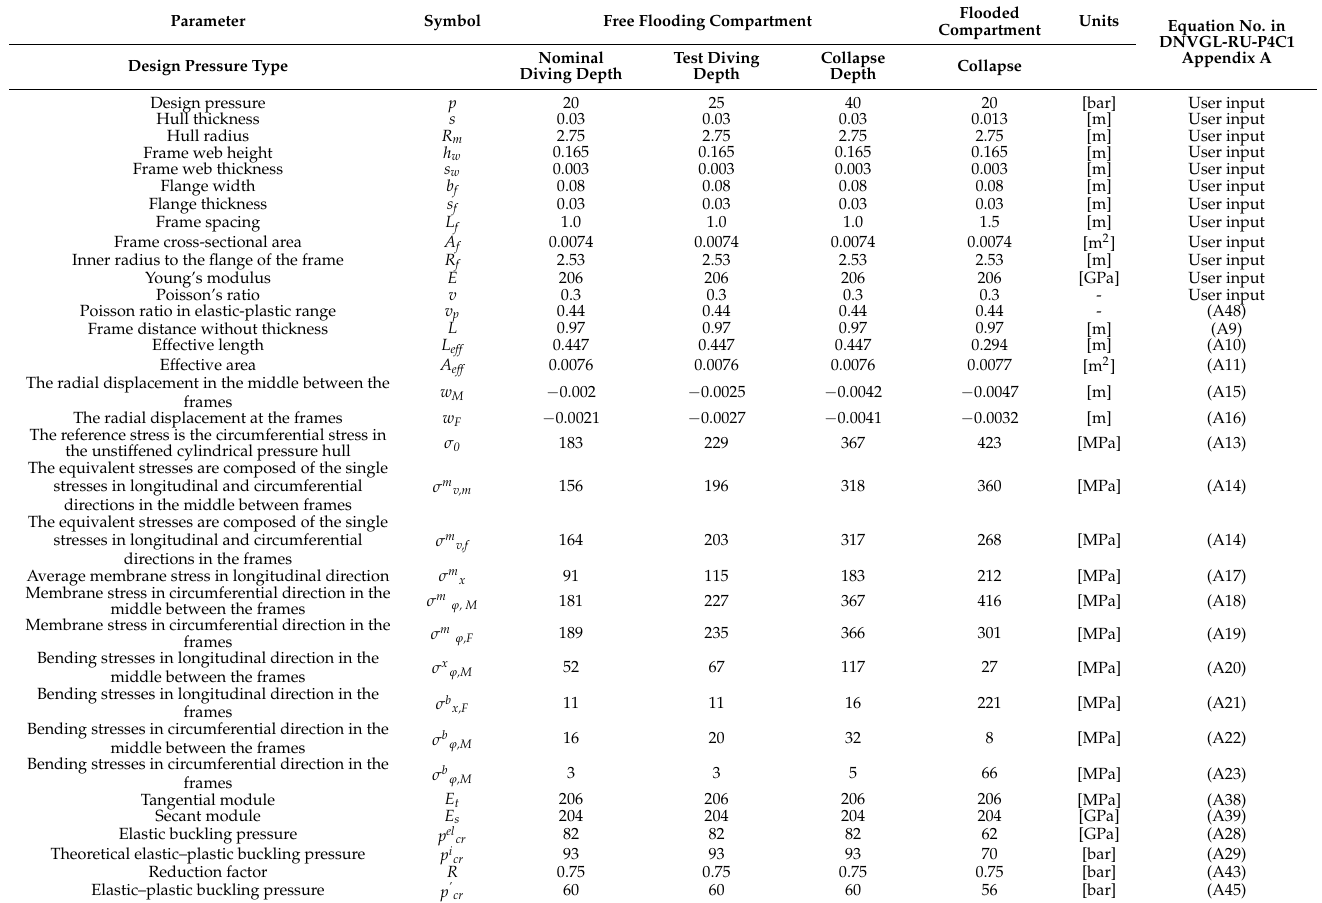
Table A1. Calculation for the external hull of the SFG baseline design.